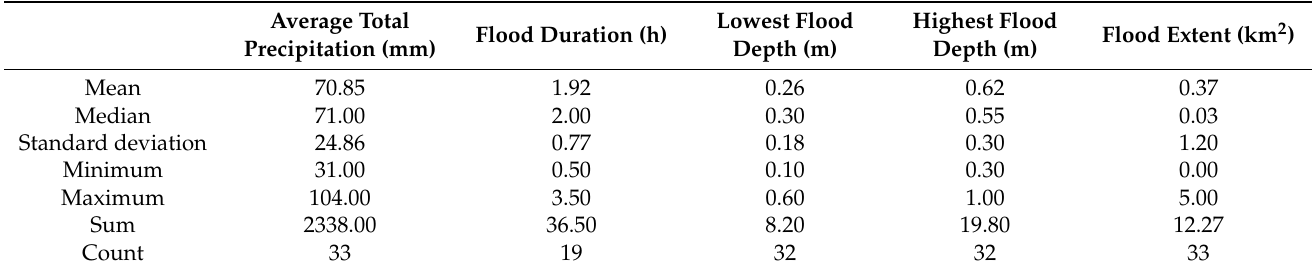
Table 1. Descriptive statistics of 2015 flood events in Damansara